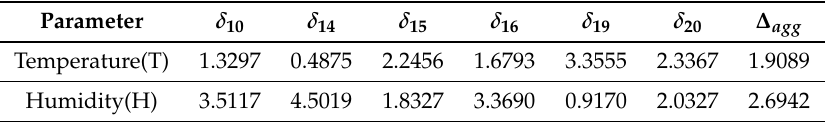
Table 5. Data accuracy of aggregation scheme.